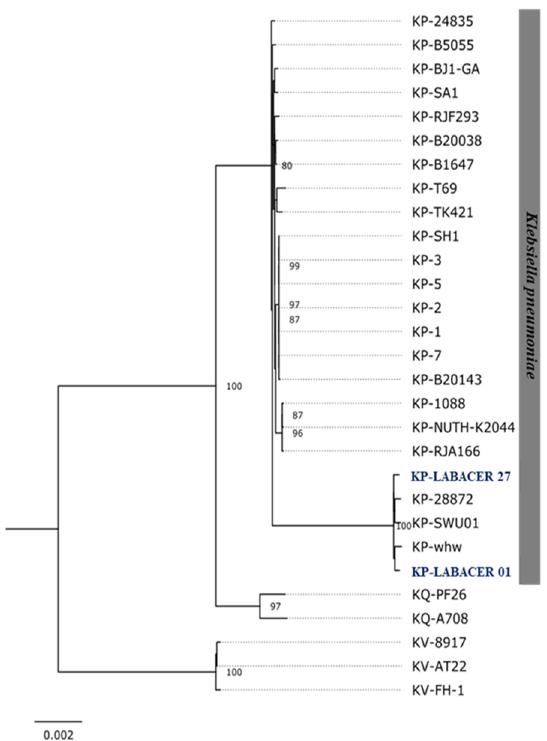
Figure 7. Phylogenetic tree constructed with sequences of genes encoding ribosomal protein subu- nits (rps) of Klebsiella pneumoniae (KP), Klebsiella quasipneumoniae (KQ), and Klebsiella variicola (KV).